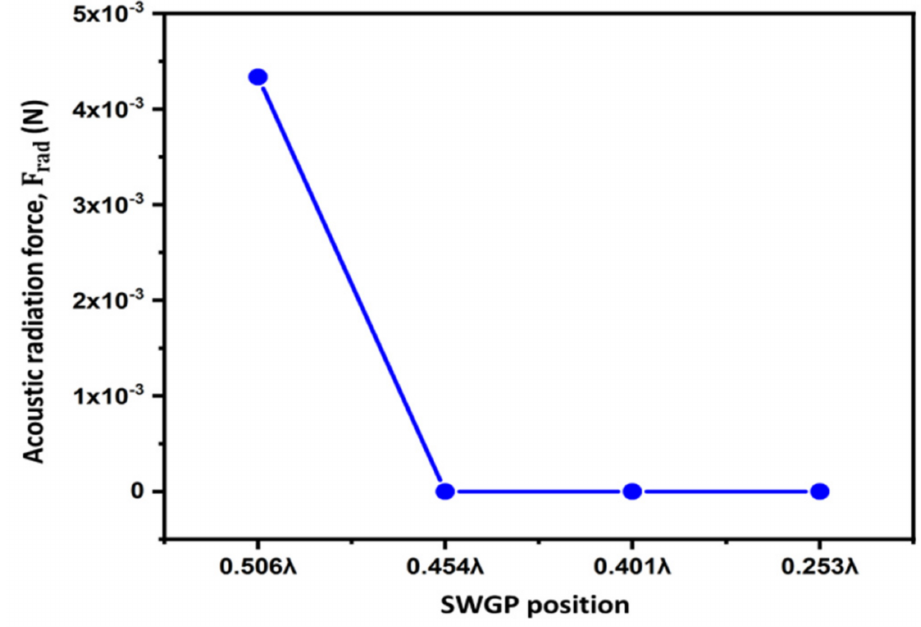
Figure 8. Acoustic radiation force on sphere droplet inside the FP resonator when the SWGP was actuated at 0.506 λ , 0.454 λ , 0.401 λ , and 0.253 λ